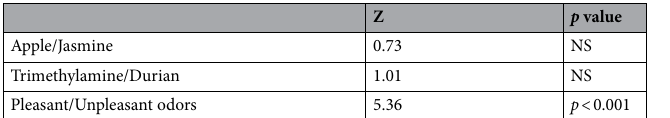
Table 2. Wilcoxon test for dependent samples of OHR at detection threshold between apple and jasmine, between trimethylamine and durian, and between odor groups (pleasant odors with apple + jasmine and unpleasant odors with durian + trimethylamine). Significant results were considered for p < 0.05. Non- significant results are noted as NS.